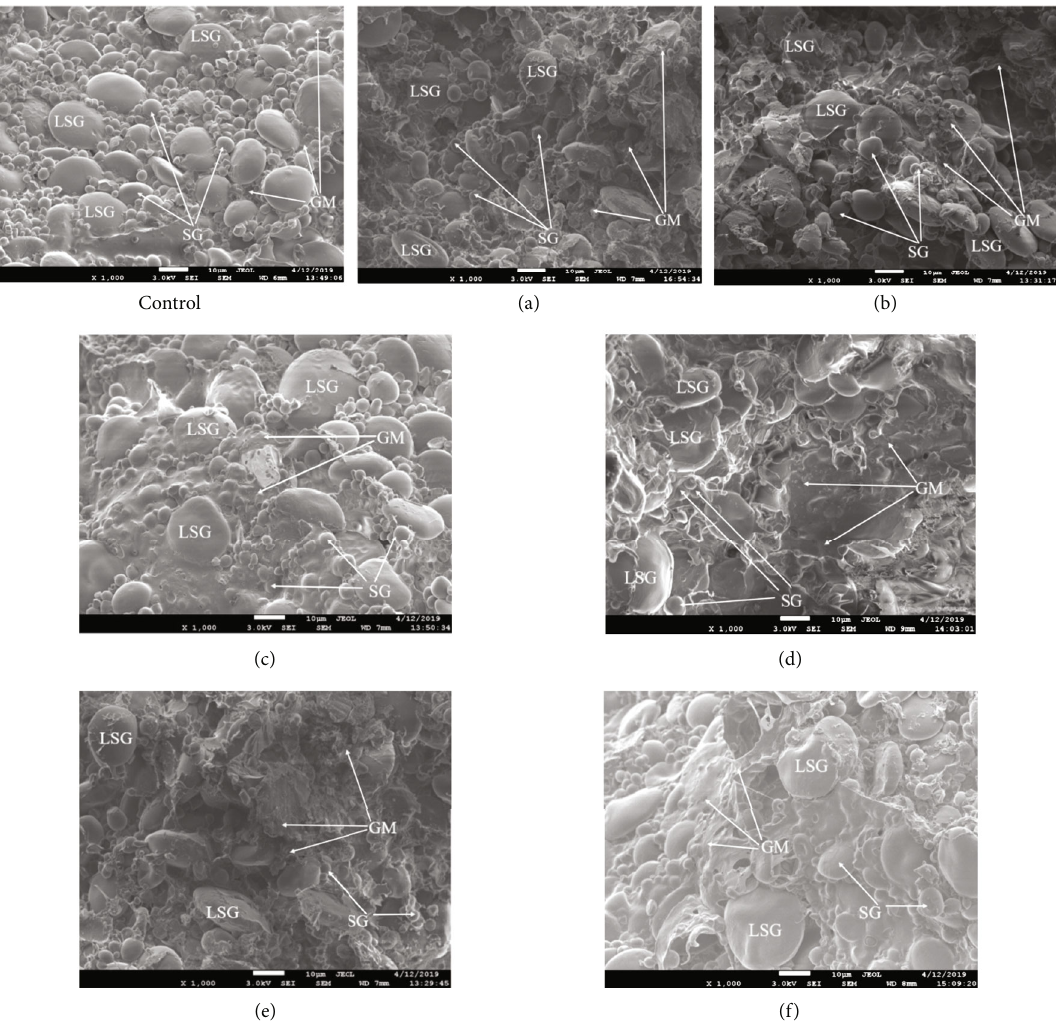
Figure 5: Results of the study of the microstructure of the dough (SEM) after 120 minutes of fermentation. LSG: large starch grains; SG: small- and medium-sized starch grains; GM: gluten